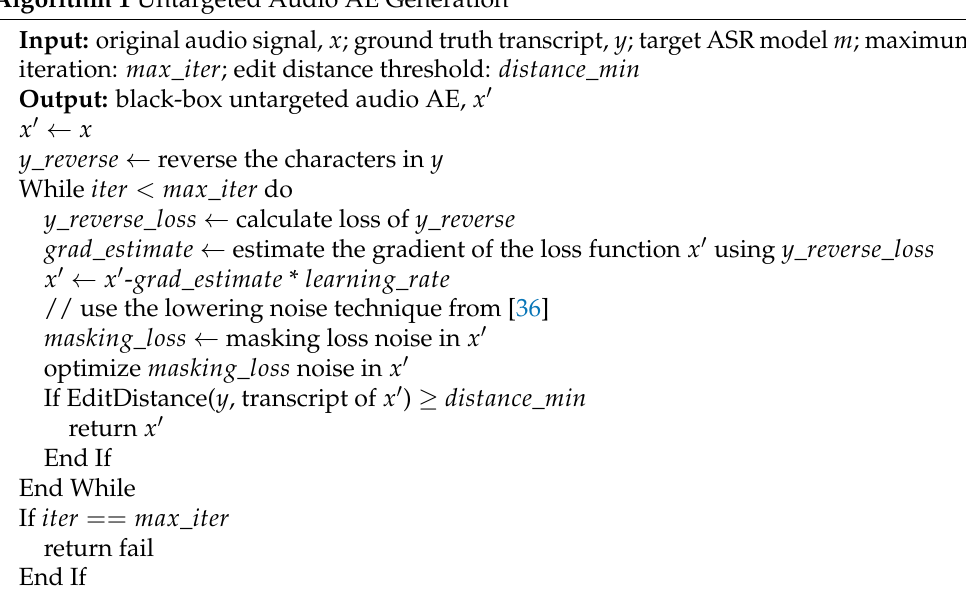
Algorithm 1 Untargeted Audio AE